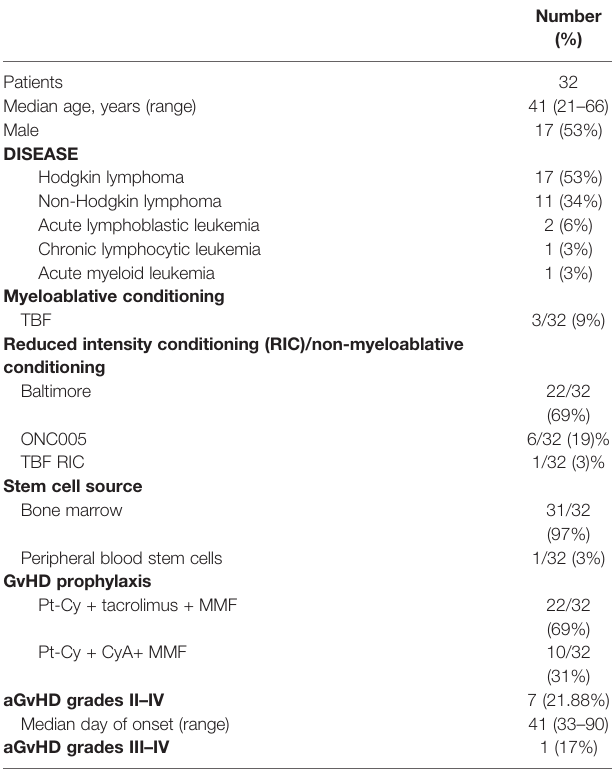
TABLE 1 | Patient and transplant